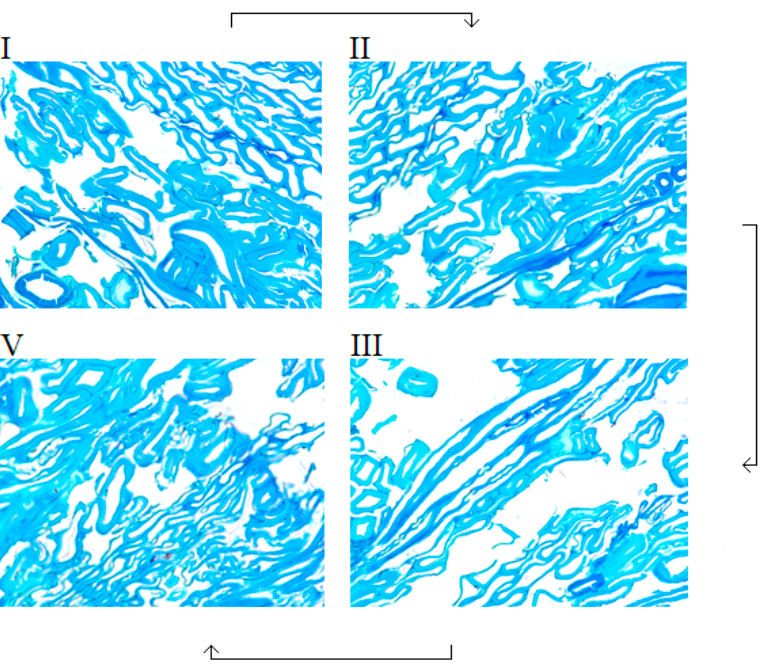
Figure 6. Four images were taken in one fiberboard slice for analyses with the Wincell software. The arrows indicate the porosity measurement sequence. I: first measurement; II: second measurement; III: third measurement; IV: fourth measurement.